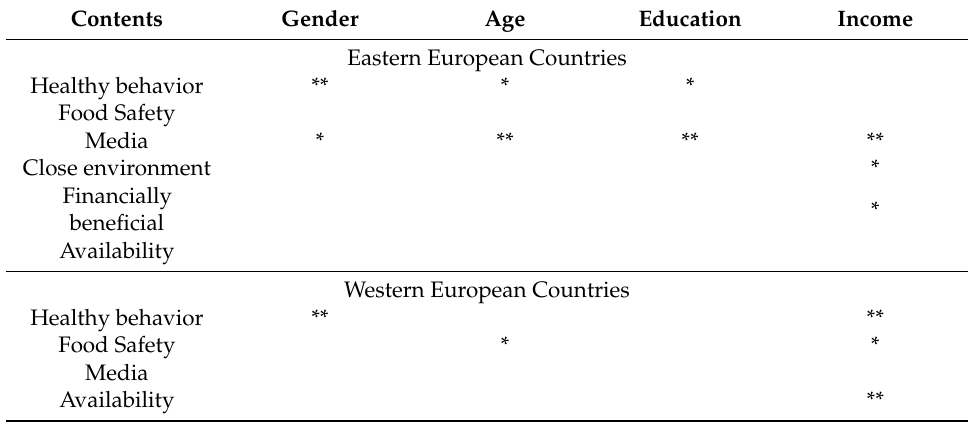
Table 7. Linear regression of socioeconomic status with factors of two subgroups, accordingly.